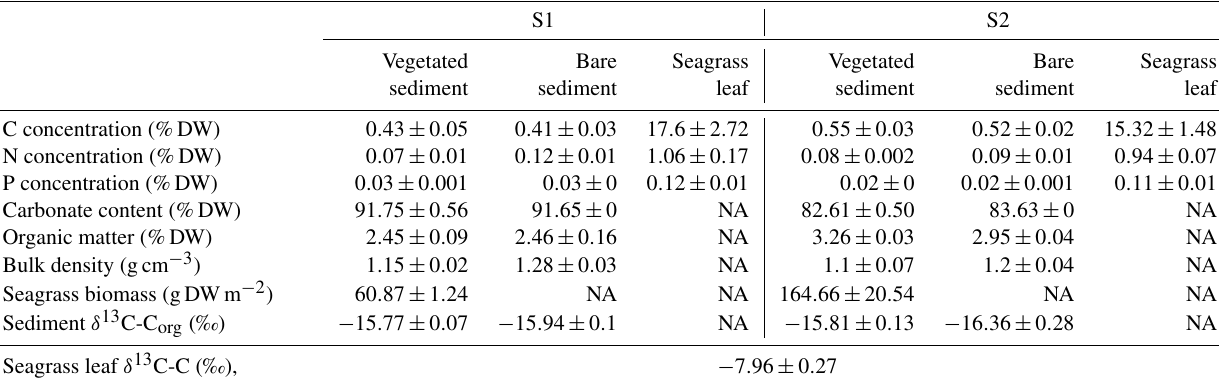
Table 1. Summary of vegetated sediment, bare sediment and seagrass leaves characteristics in the study sites (S1 and S2). NA: not available. S1 S2 Vegetated Bare Seagrass Vegetated Bare Seagrass sediment sediment leaf sediment sediment leaf C concentration